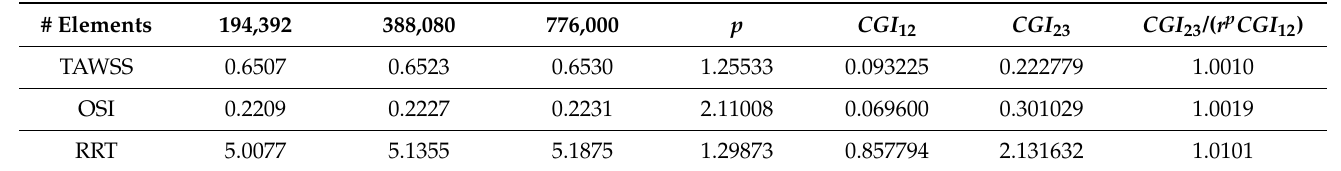
Table 3. Convergence Grid Index for the 31A, Cs, Parabolic case, and convergence rates for TAWSS, OSI, and